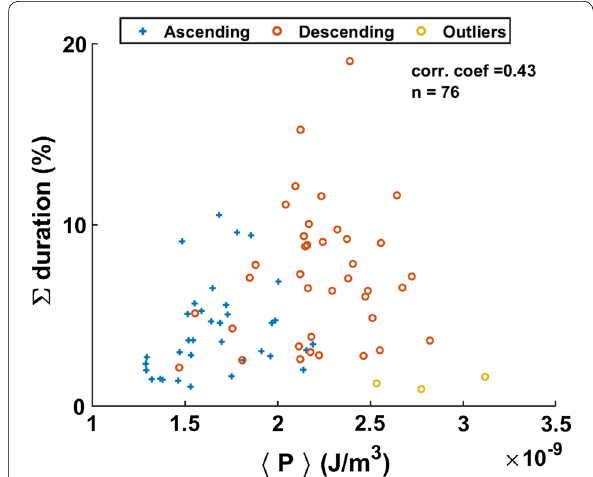
Fig. 9 Monthly percentage of duration of EMIC waves as a function of monthly averaged value of solar wind dynamic pressure, which is equivalent to the twice of solar wind kinetic energy density ( P = 2 E ke ) at the Earth’s bow-shock nose. The correlation coefficient between them is mentioned in the